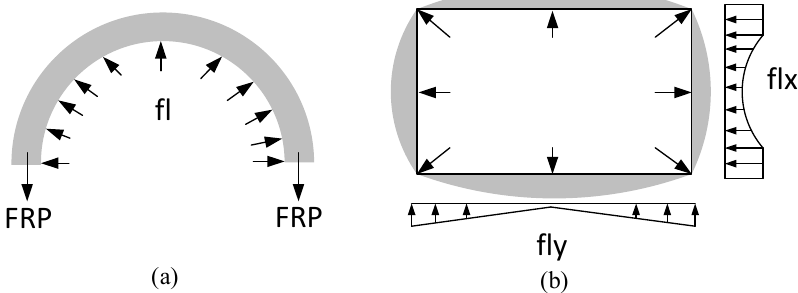
Figure 9. The distribution of confining stress with ( a ) circular and ( b ) non-circular cross-sections, the confining pressure, and FRP longitudinal tensile strength.